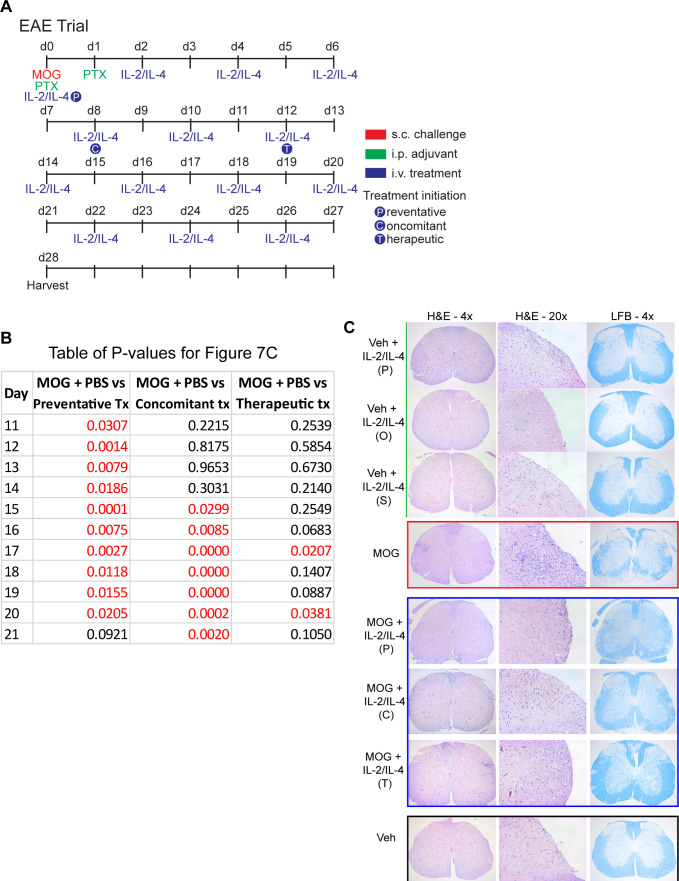
Combined IL-2 and IL-4 suppressed the severity of experimental autoimmune encephalomyelitis (EAE) in preventative, concomitant, and therapeutic dosing regiment.(A) EAE was induced in mice with s.c. injections of myelin oligodendrocyte glycoprotein emulsified in Complete Freund’s Adjuvant (CFA) and d0. Pertussis toxin (PTX) was injected i.p. on days 0 and 1. Negative control mice received CFA only with PTX. The combinatorial cytokines were delivered i.v., with the Preventative regimen beginning on d0, Concomitant regimen on d8, and Therapeutic regimen on d12. Mice that did not receive the combinatorial cytokines received i.v. PBS as the vehicle control. Related to Figure 7. (B) Table of p-values for Figure 7C. Red font represents p≤0.05. Black font represents p>0.05. N = 10–12 for EAE mice, N = 4 for vehicle control mice. Related to Figure 7C. (C) Histological analysis of disease through FFPE-processed spinal cords undergoing H and E or LFB staining. Images represent a mouse of the mean disease score of each condition. N = 10–12 for EAE mice, N = 4 for vehicle control mice. Related to Figure 7C.